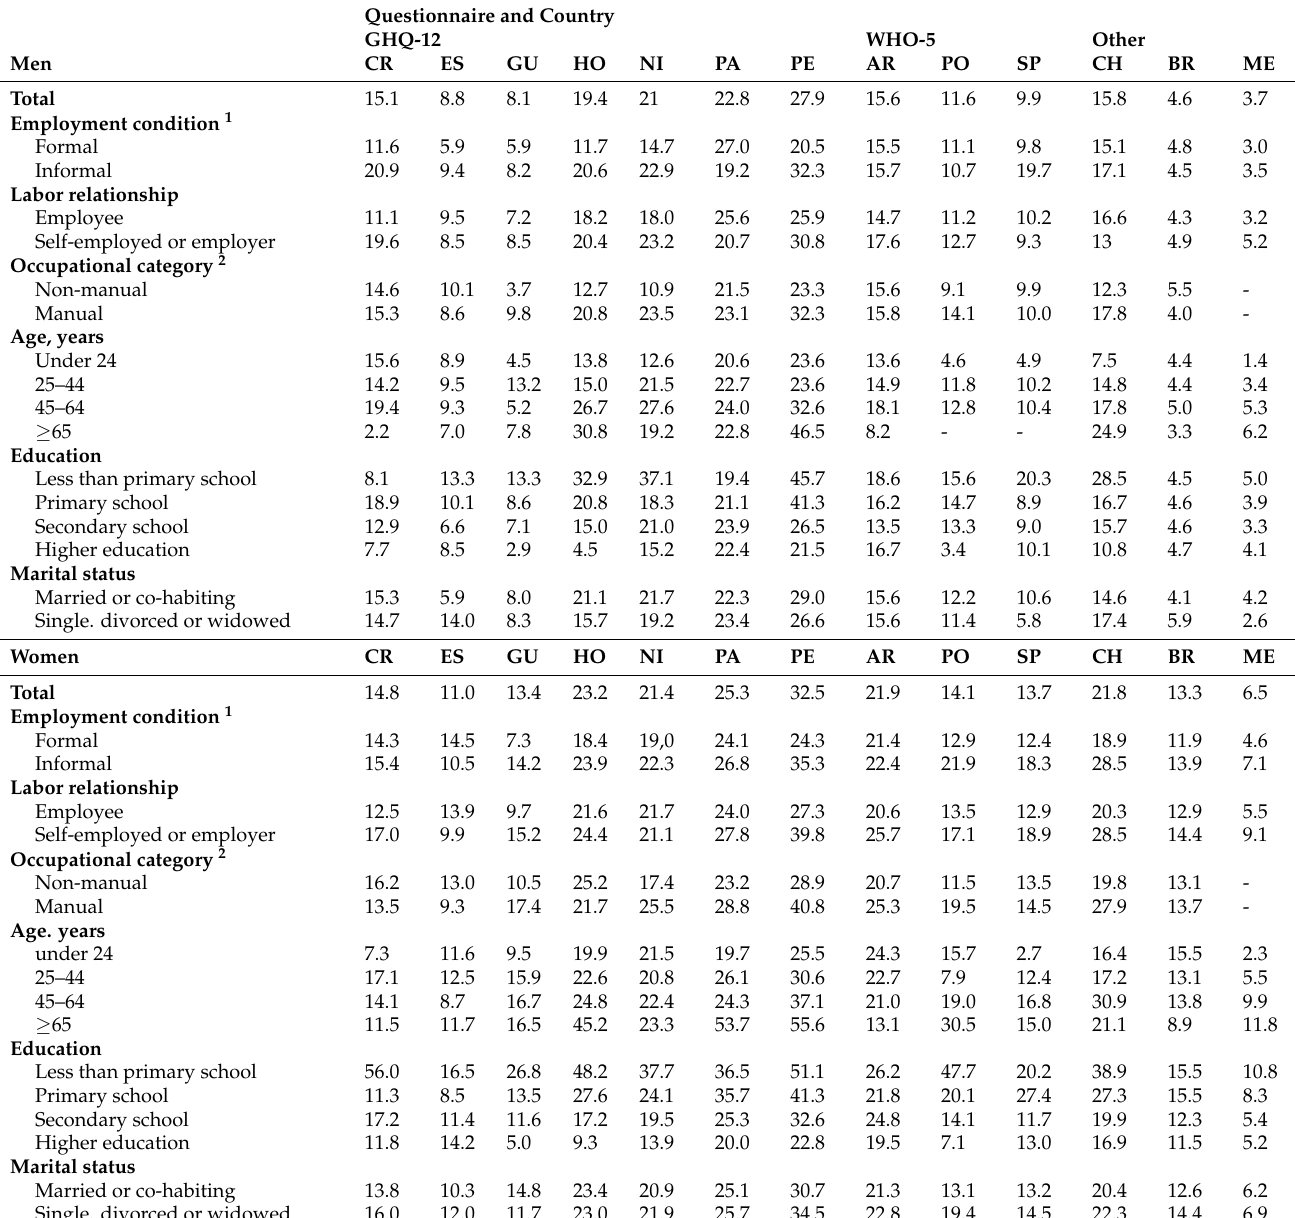
Table 2. Prevalence of poor mental health (%) according to work and sociodemographic variables, by questionnaire, country, and